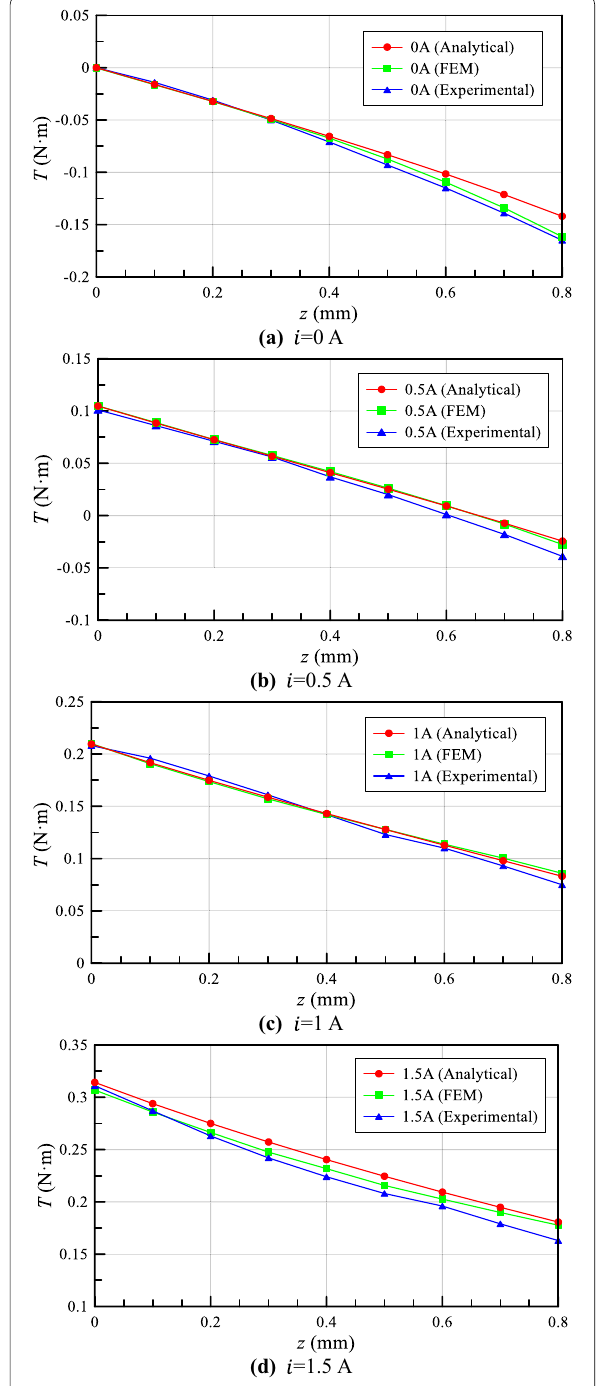
Figure 23 Torque-displacement characteristics of